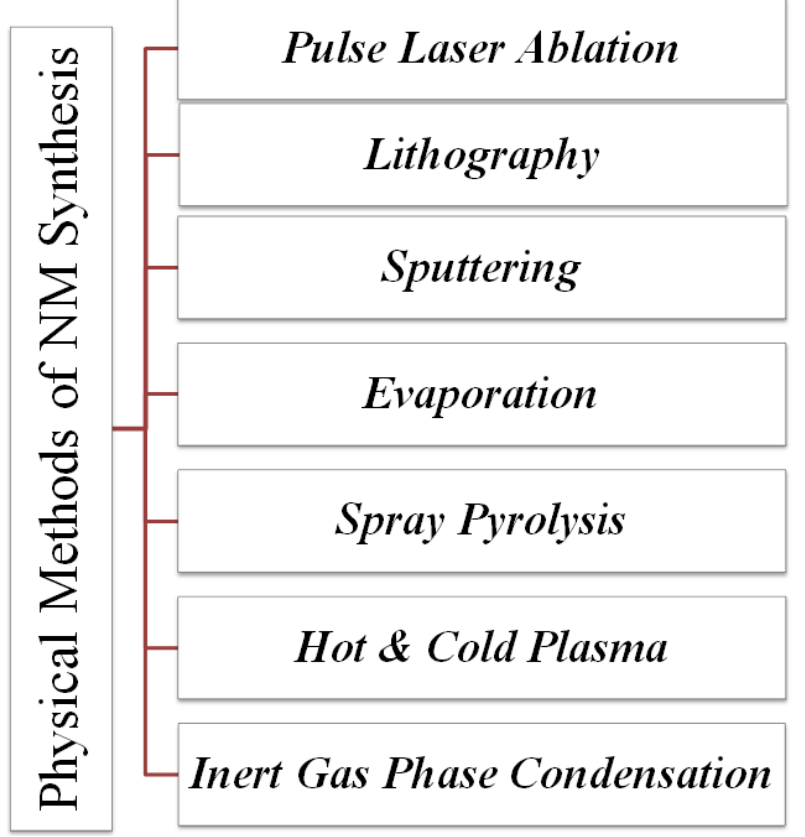
Figure 4. Physical methods for the synthesis of 2D nanomaterial.